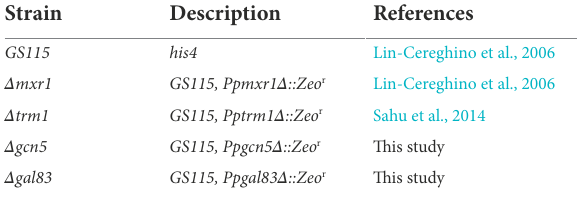
TABLE 1 Komagataella phaffii strains used in this